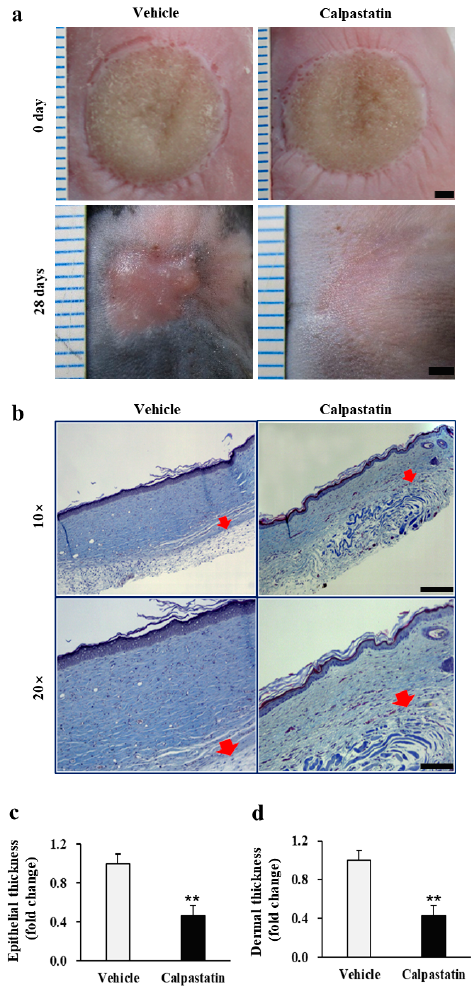
Figure 7. Effect of calpastatin on post-burn scar formation in mice. ( a ) Wound images of vehicle control and calpastatin-treated mice showing less discoloration and irregular thickening in the burn skin wound after the calpastatin treatment. Unit of rulers, 1 mm. Scale bars = 2 mm. ( b ) Histological images of burn skin wounds of calpastatin-treated mice obtained by Masson’s trichrome staining showing decreased epidermal and dermal thicknesses. Scale bar = 100 μ m at 10×. The arrows indicate the border between the dermis and subcutaneous tissue. Quantitative analysis of ( c ) epidermal and ( d ) dermal thicknesses of vehicle-treated (vehicle) and calpastatin-treated (calpastatin) burn wounds in mice. Thicknesses were normalized to those of the vehicle-treated mice, in which the mean value of vehicle controls was set as value 1. ** p < 0.01. Data represent mean ± standard error of the mean; n = 36 (vehicle) and n = 36 (calpastatin).